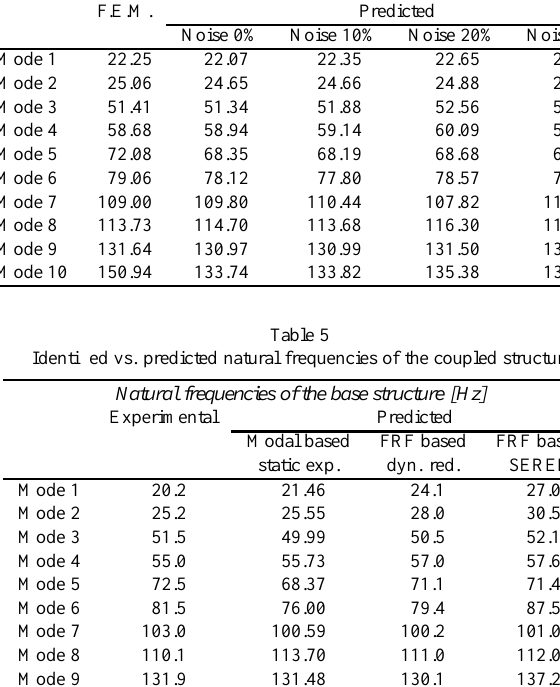
Table 4 Finite element vs. predicted natural frequencies of the coupled structure Natural frequencies of the base structure [Hz] F.E.M.